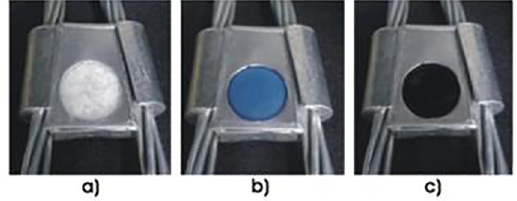
Figure 10. Temperature sensor assembled in wedge-type connector: (a) at room temperature; (b) with heating and cooling between 80 and 90 °C; (c) above 100